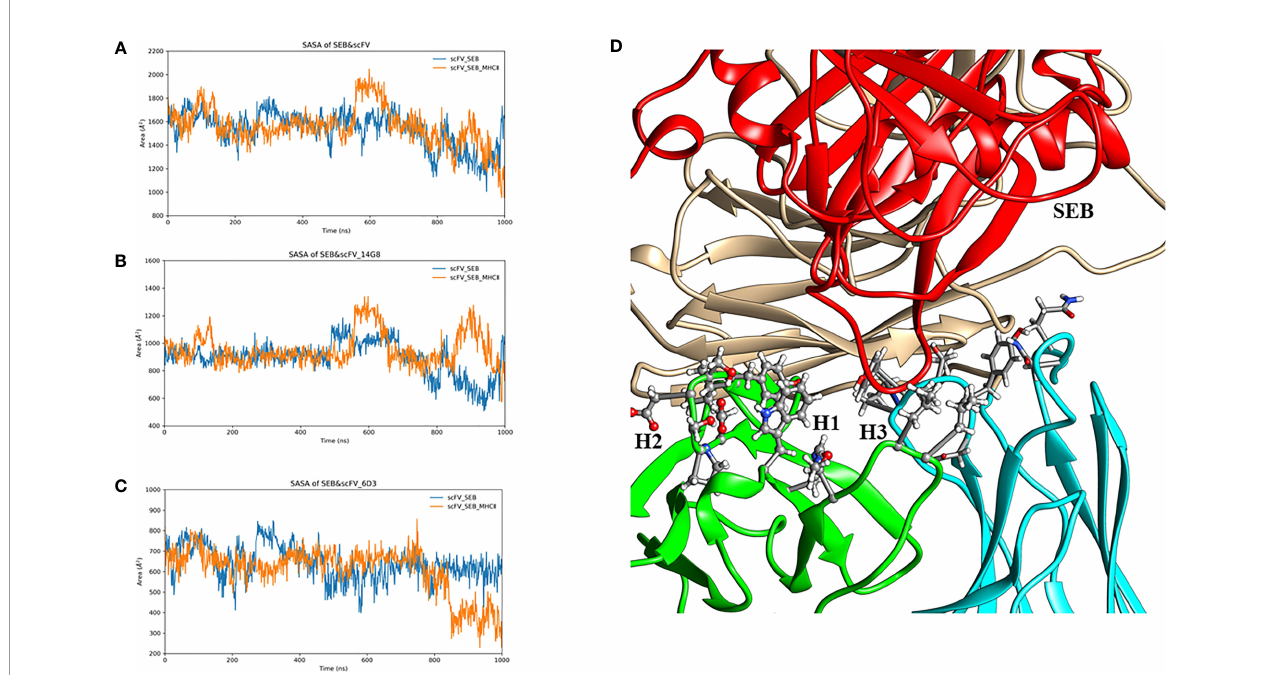
FIGURE 5 | 14G8 interact with SEB stronger than 6D3. Contact surface areas of SEB with all MB102a scFV (A) , with 14G8 variable domain (B) , and with 6D3 variable domain (C) . (D) illustrated of SEB interaction with 6D3 variable domain in the last snapshot of 1000 ns simulation.